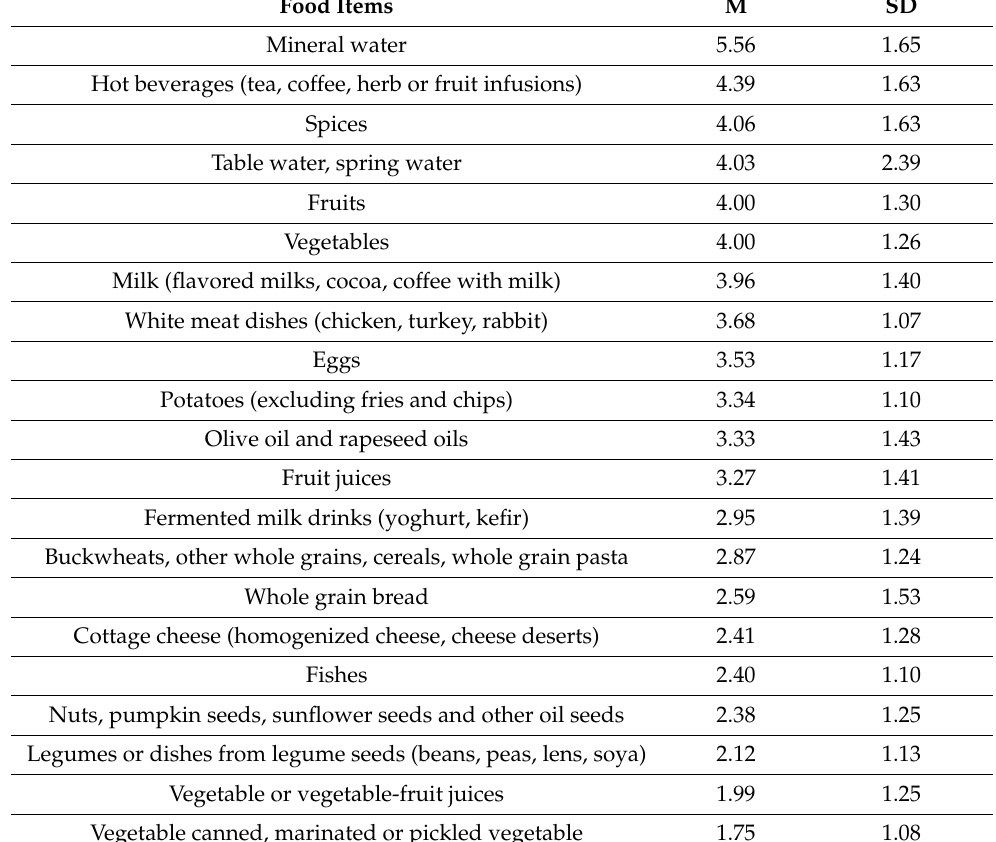
Table 1. The average consumption frequency (frequency/day) of food items positively influencing brain